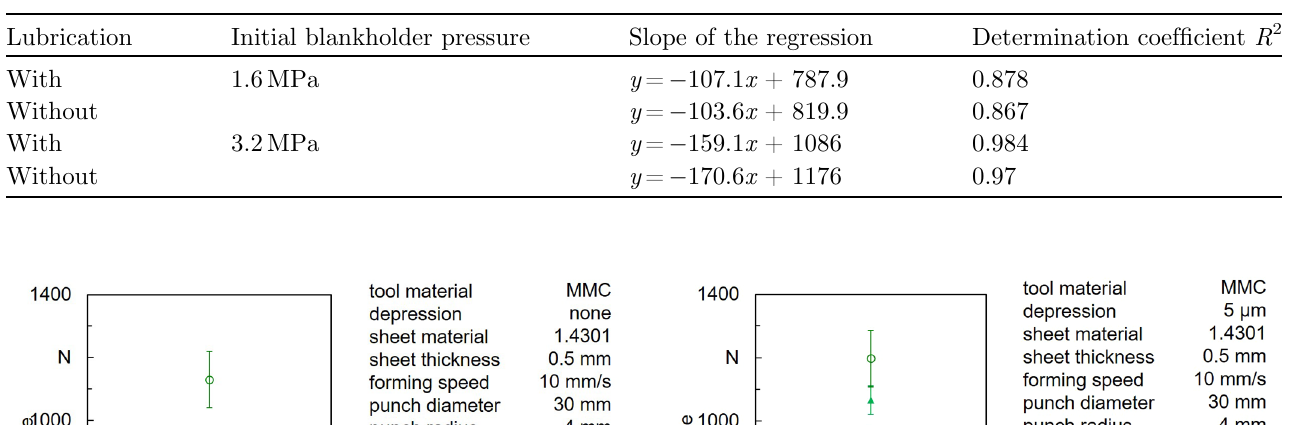
Table 8. Regression analysis of variation of the drawing radius in the case of using steel tool.